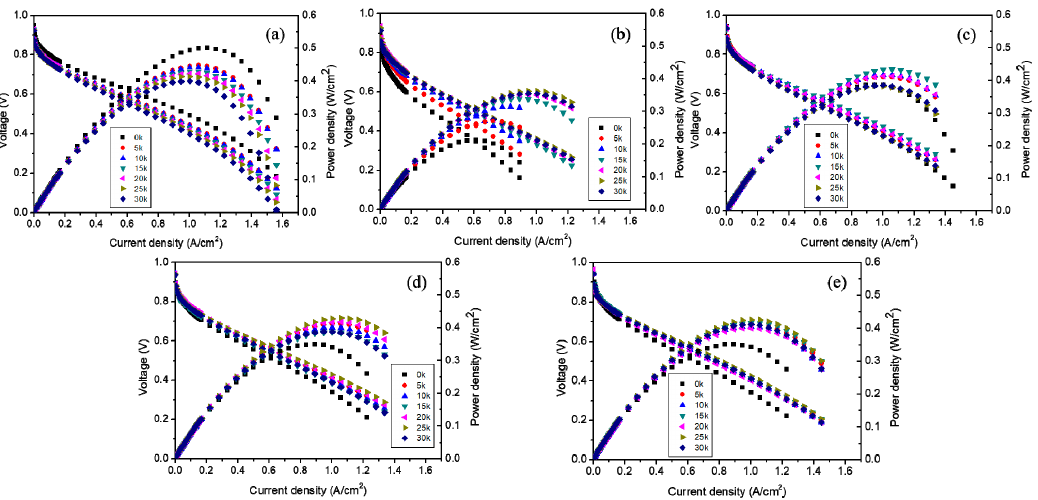
Figure 3. Fuel cell polarization plots after 5, 10, 15, 20, 25, and 30k potential cycles: ( a ) 2.5 wt.% water–IPA; ( b ) 2.5 wt.% NMP; ( c ) 2.5 wt.% water–IPA+2.5 wt.% NMP; ( d ) 5 wt.% water–IPA+adding NMP; and ( e ) 5 wt.% NMP+adding water–IPA.